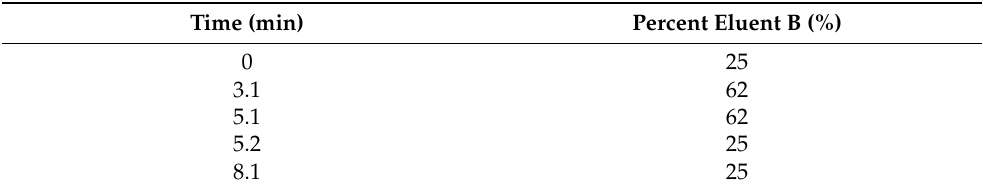
Table 1. Gradient used for the RPLC analysis, with eluent A being ultrapure water and eluent B acetonitrile both supplemented with 0.1% (v/v) trifluoroacetic acid. Time